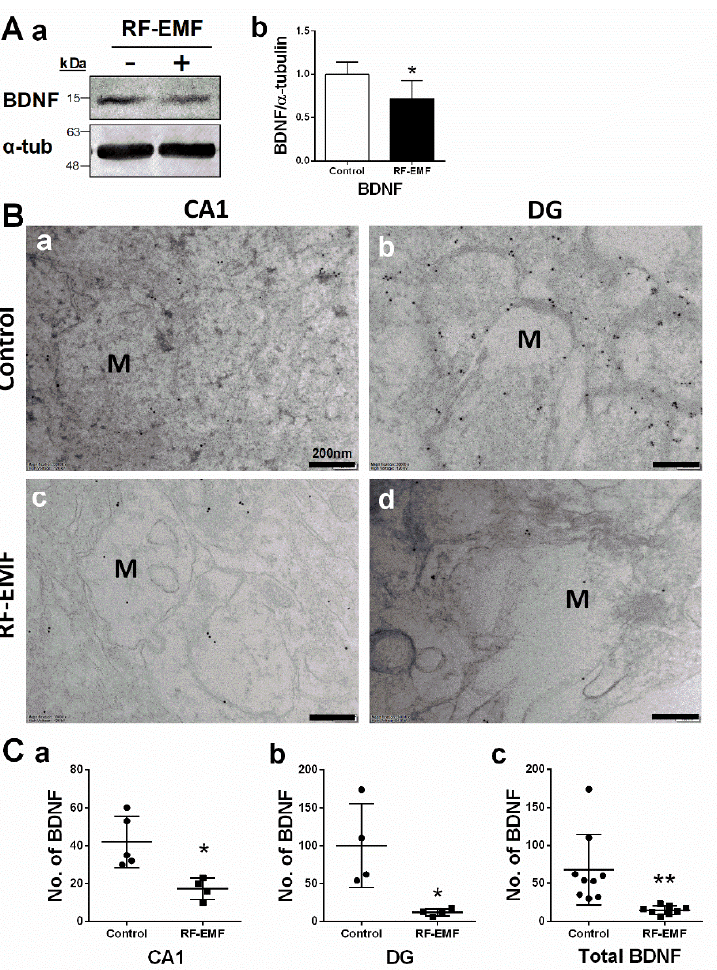
Figure 3. Expression levels of BDNF in the hippocampus of RF-EMF-exposed early postnatal mice. ( A ). Protein expression levels of BDNF in mouse hippocampus (control n = 5 mice, RF-EMF n = 5 mice). Total protein was immunoblotted with an antibody against BDNF ( a ). The intensities of bands were quantified by densitometry ( b ). Protein levels were normalized relative to α -tubulin. ( B ). Representative immunogold staining for BDNF in hippocampal CA1 ( a , c ) and DG ( b , d ) in control ( a , b ) and RF-EMF-exposed mice ( c , d ). Gold particles labeling BDNF were observed by transmission electron microscopy. ( C ). The total number of gold particles labeling BDNF ( c ) in hippocampal CA1 ( a ) and DG ( b ) were quantified in hippocampal neurons. Data are expressed as means ± SD. Statistical significance was evaluated using the Student’s t -test. * p < 0.05, ** p < 0.01 vs. control (control n = 4 mice, RF-EMF n = 4 mice). M, mushroom; • Control; (cid:4) RF-EMF. Scale bars = 200